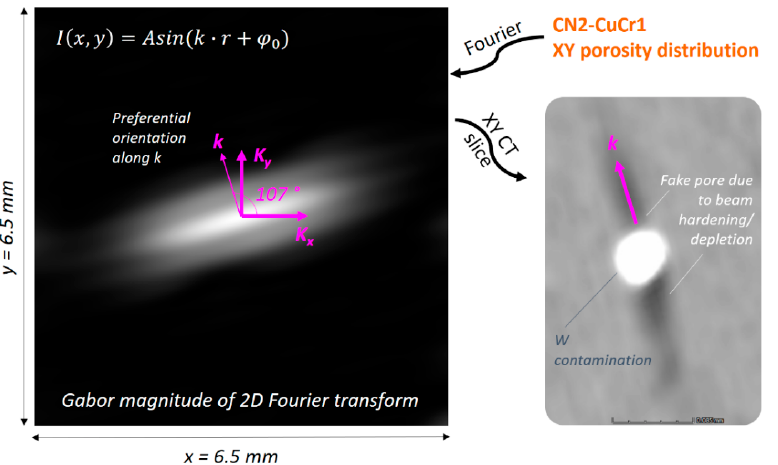
Figure 12. Gabor magnitude of the 2D Fourier transform for the CN2-CuCr1 CT dataset (XY plane), to highlight preferential spatial frequencies; the repeating pattern oriented at 107° is identified as a streaking artefact generated by the W contaminants due to X-ray beam hardening and partial beam depletion.